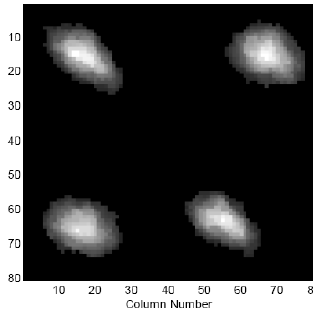
Fig. 2 Example Guide stars image